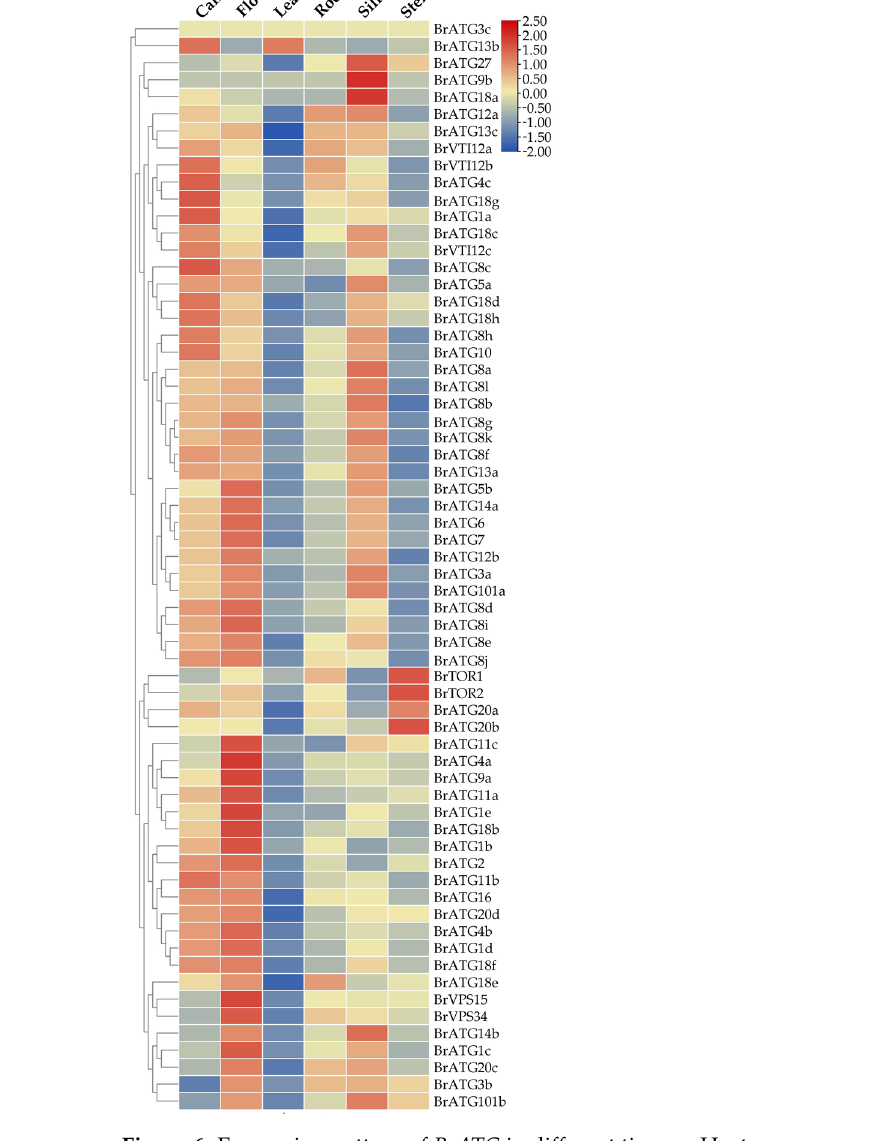
Figure 6. Expression pattern of BrATG in different tissues. Heat map was constructed using TBtools software based on the FPKM values of BrATG gene in different tissue transcriptome data.